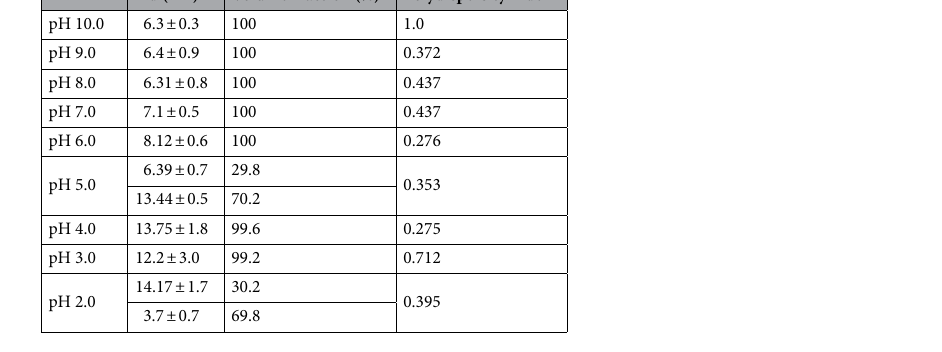
Table 2. Effect of different pH (2.0–10.0) on hPrdx6’s hydrodynamic diameter